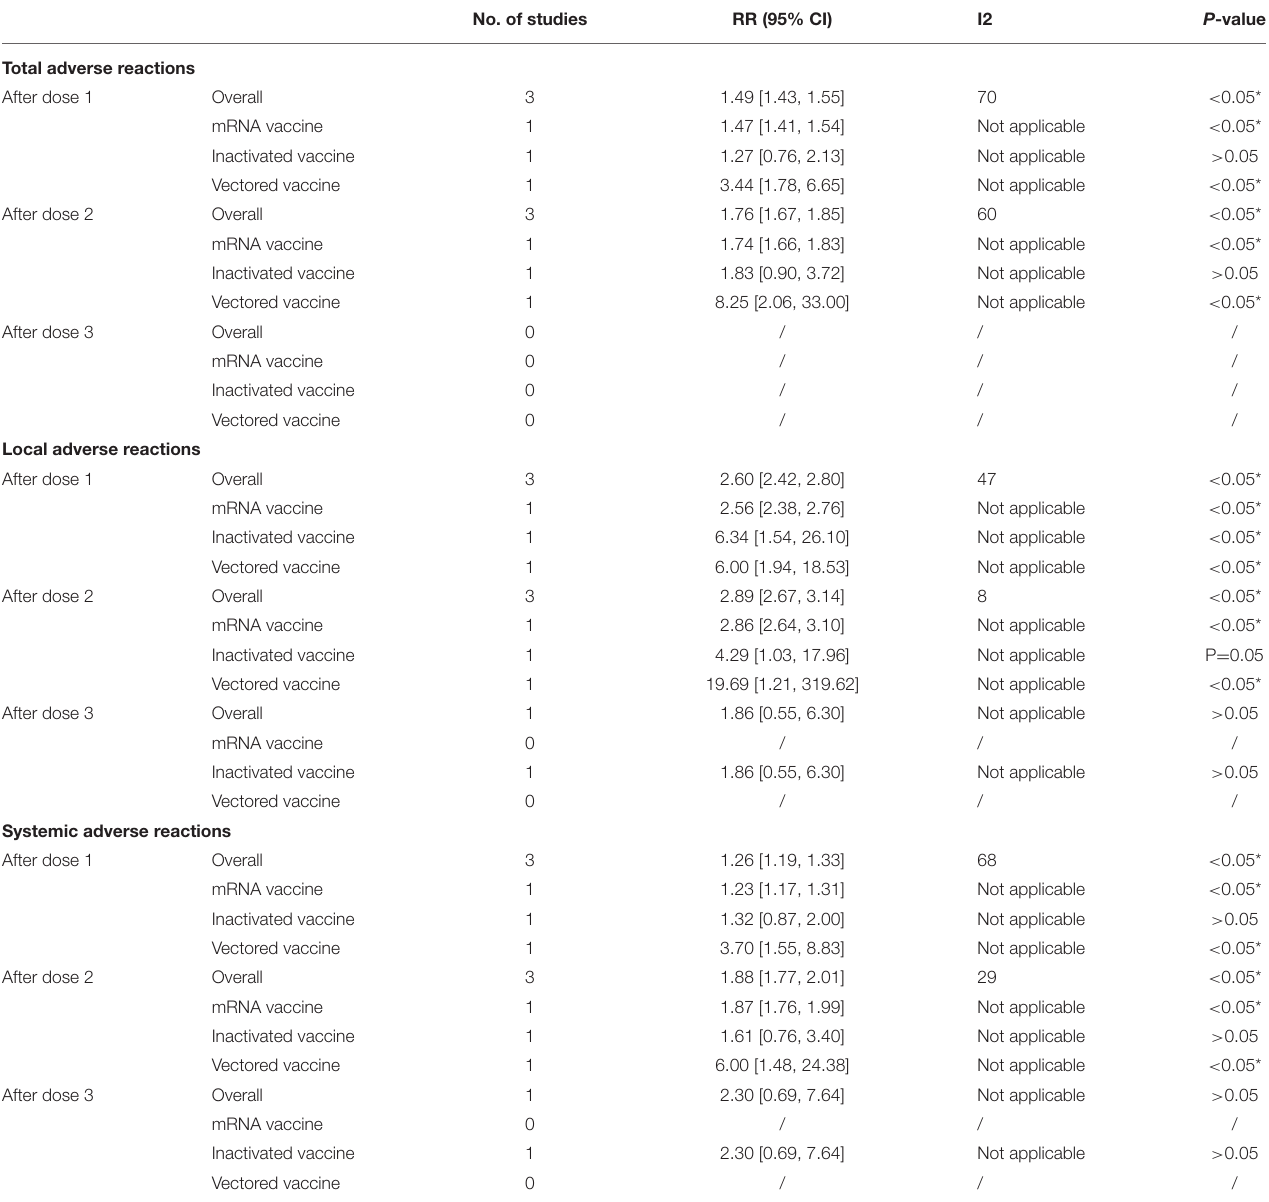
TABLE 5 | Adverse reactions among vaccination group vs. control group. No. of studies P